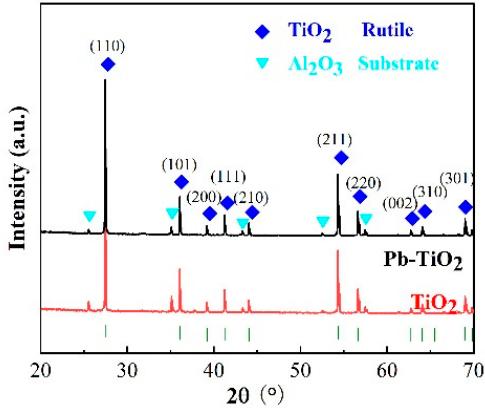
Figure 2. XRD patterns of TiO 2 and Pb-TiO 2 .